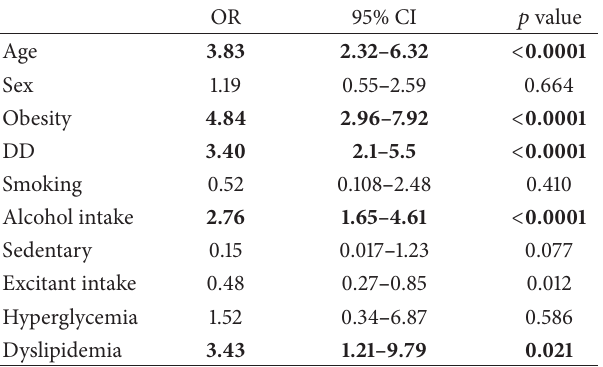
Table 4: Multinomial logistic regression analysis for hypertension risk